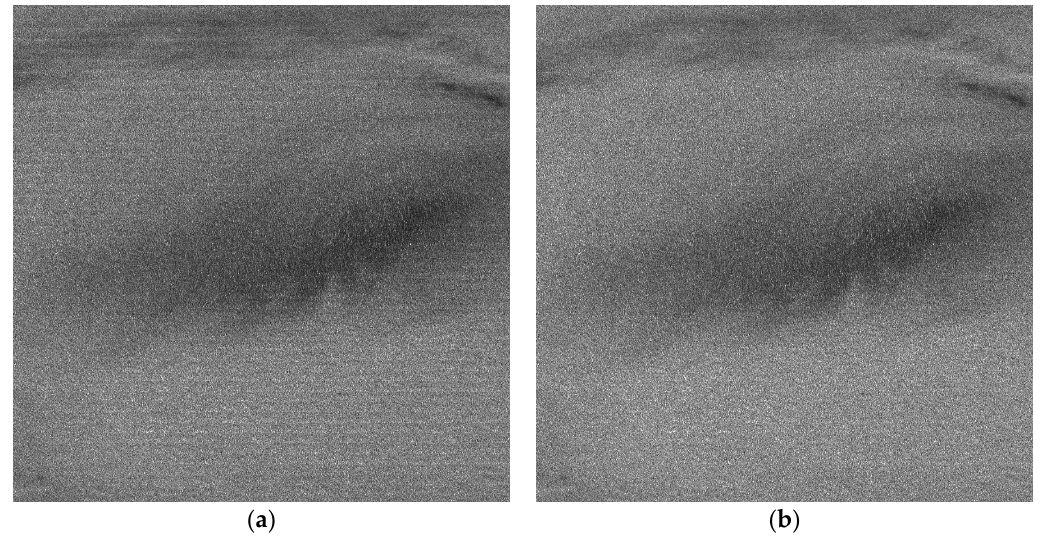
Figure 16. Comparation before and after descalloping of the typhoon eye: ( a ) Frame 1 of Figure 15 before descalloping; ( b ) image after descalloping of ( a ).